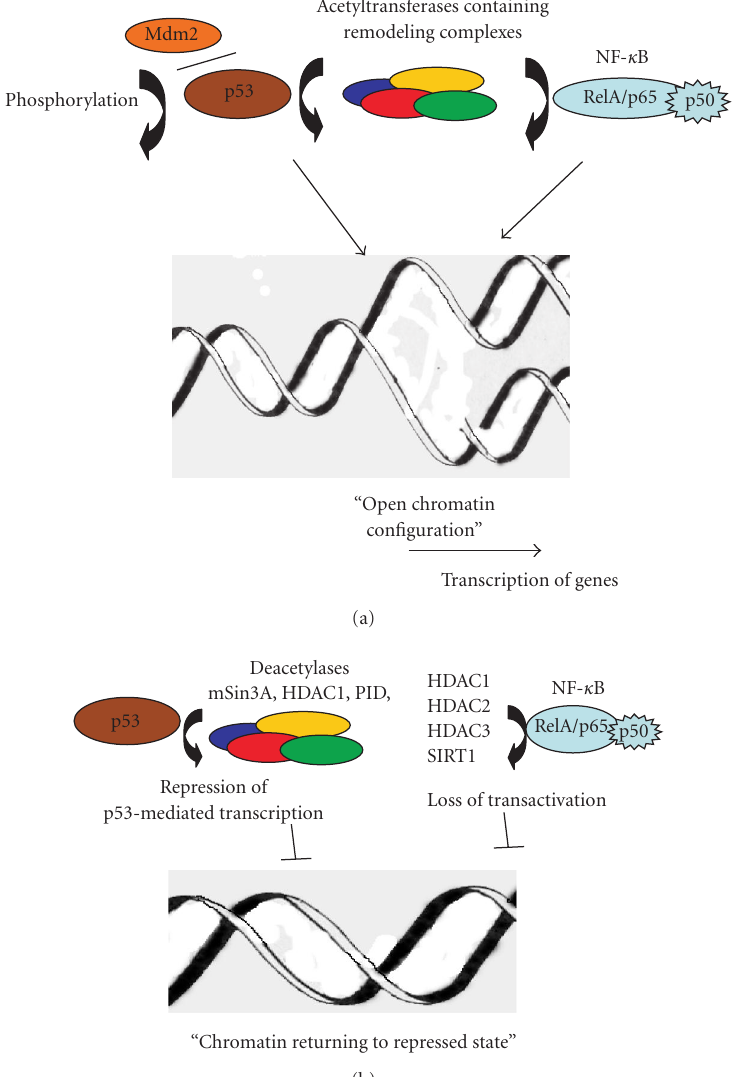
Figure 2: Roles of acetylation/deacetylation of p53 and NF- κ B in transcriptional regulation. (a) Interaction of p53 with acetylases facilitates alteration of chromatine structure by histone acetylation and association of transcription complex machinery; p53 is itself subject to acety- lation. NF- κ B becomes attached to acetyltransferases containing complexes facilitating an “open chromatin” configuration and the binding of transcription factors and RNA polymerase II. (b) Deacetylases regulate p53 and NF- κ B- mediated transcription, possibly by inducing a “repressed chromatin”